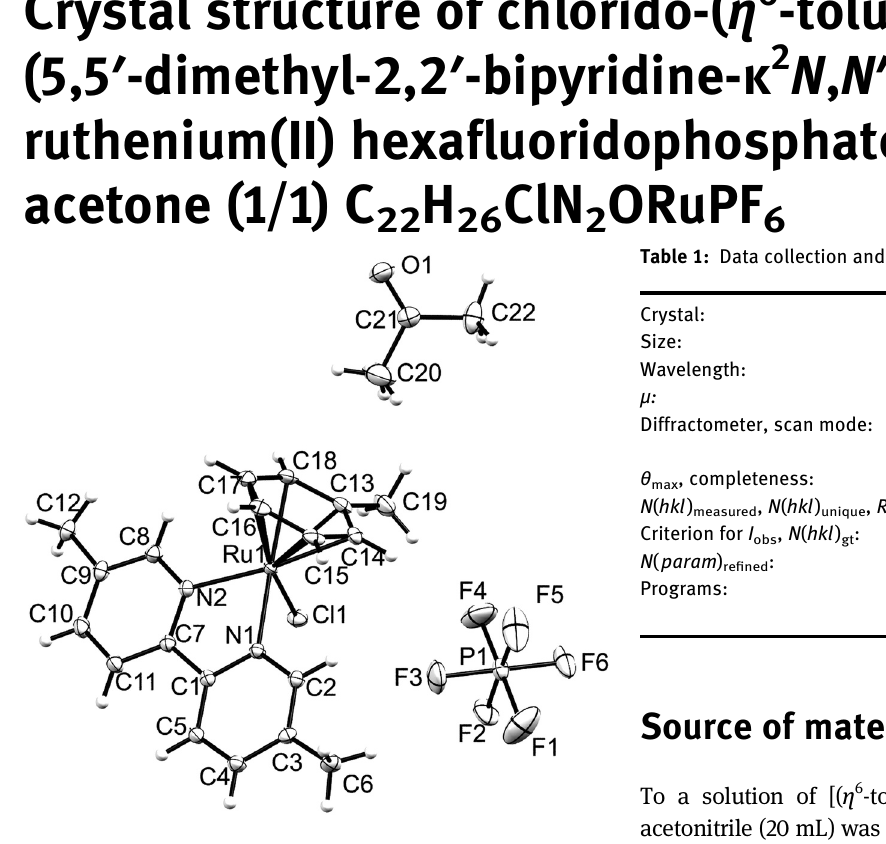
Table 1 contains crystallographic data and Table 2 contains the list of the atoms including atomic coordinates and displacement